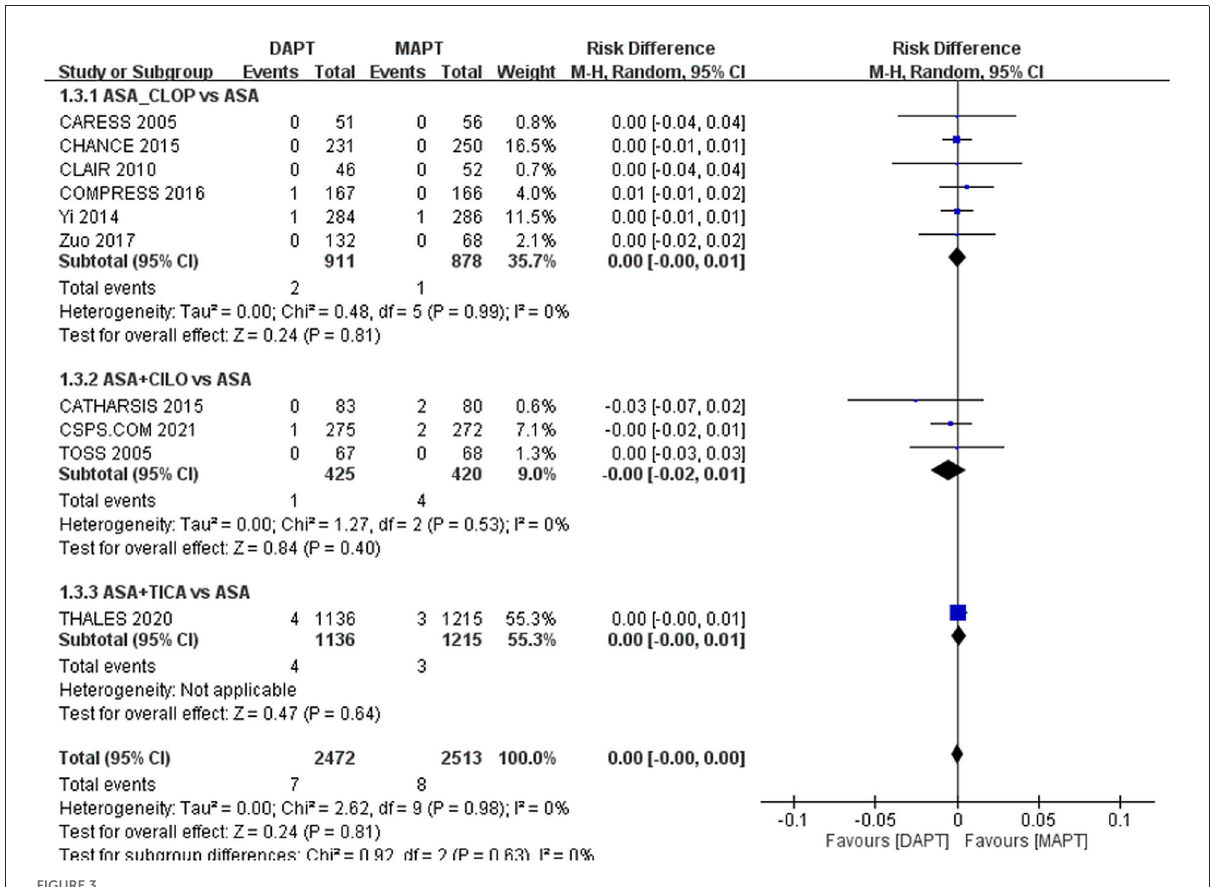
FIGURE3 Forest plot for outcome of intracranial hemorrhage. The risk of intracranial hemorrhage was not significantly different between MAPT and DAPT in patients with symptomatic large artery atherosclerosis. ASA, aspirin; CILO, cilostazol; CLOP, clopidogrel; DAPT, dual antiplatelet therapy; MAPT, mono antiplatelet therapy, M-H, Mantel-Haenszel method; TICA,